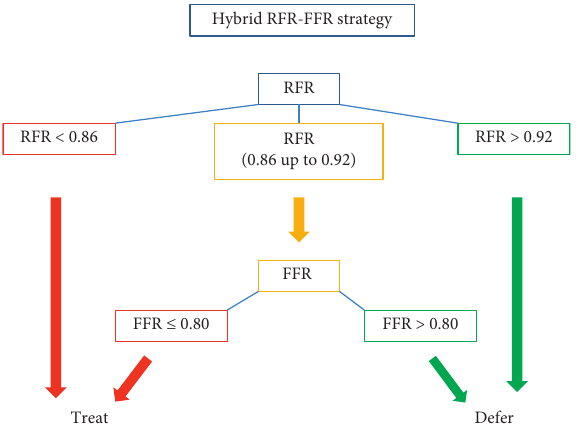
Figure 5: Diagnostic-therapeutic algorithm proposal according to a hybrid RFR-FFR strategy. Initially, the RFR will be performed to assess the hemodynamic significance of the coronary lesions to be evaluated. If the RFR value is inferior to 0.86, the lesion will be treated. In case the RFR value is superior to 0.92, the treatment of the lesion will be deferred. In the intermediate RFR values (from 0.86 to 0.92, with both included), the significance of the coronary lesion will be reclassified by determining the FFR. Lesions with FFR values less than or equal to 0.80 will require treatment. In those lesions with FFR values greater than 0.80, the treatment should be